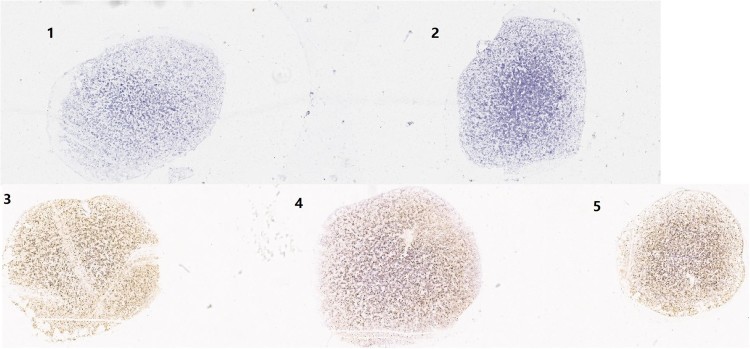
ScanScope images of the three HBoV2 mRNA transcripts at 72 h
post-transfection. 1: HEK293 cells transfected with pBlueScript; 2: Untreated HEK293
cell control; 3: HEK293 cells transfected with pBlueScript-HBoV2 5043–5042; 4:
HEK293 cells transfected with pBlueScript-HBoV2 5075–5074; 5: HEK293 cells
transfected with pBlueScript-HBoV2 5220–5219.